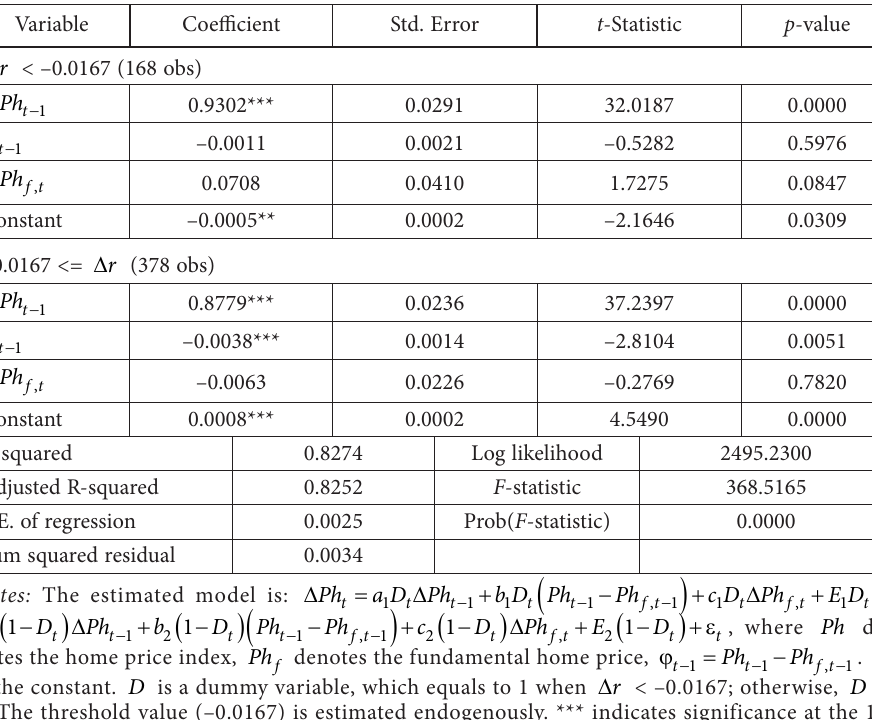
Table 8. Asymmetric effects of interest rates on home price behavior Variable Coefficient Std. Error t -Statistic p